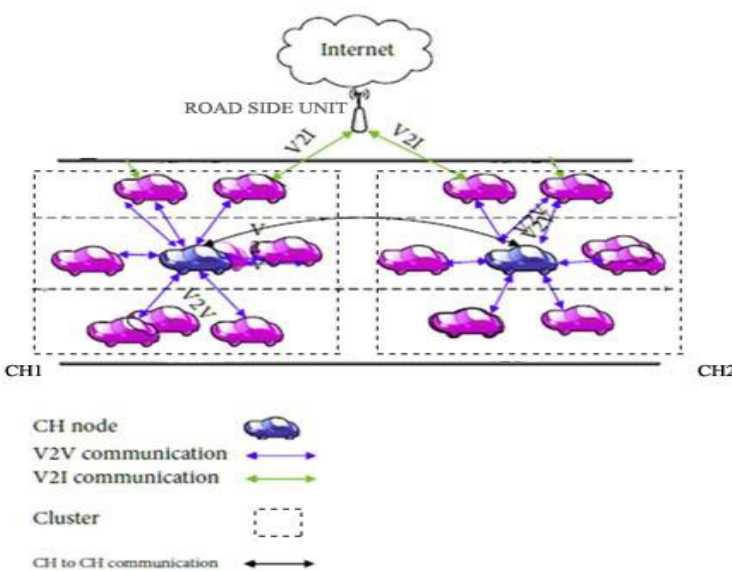
Figure 2. Clustering in VANETs [21] .